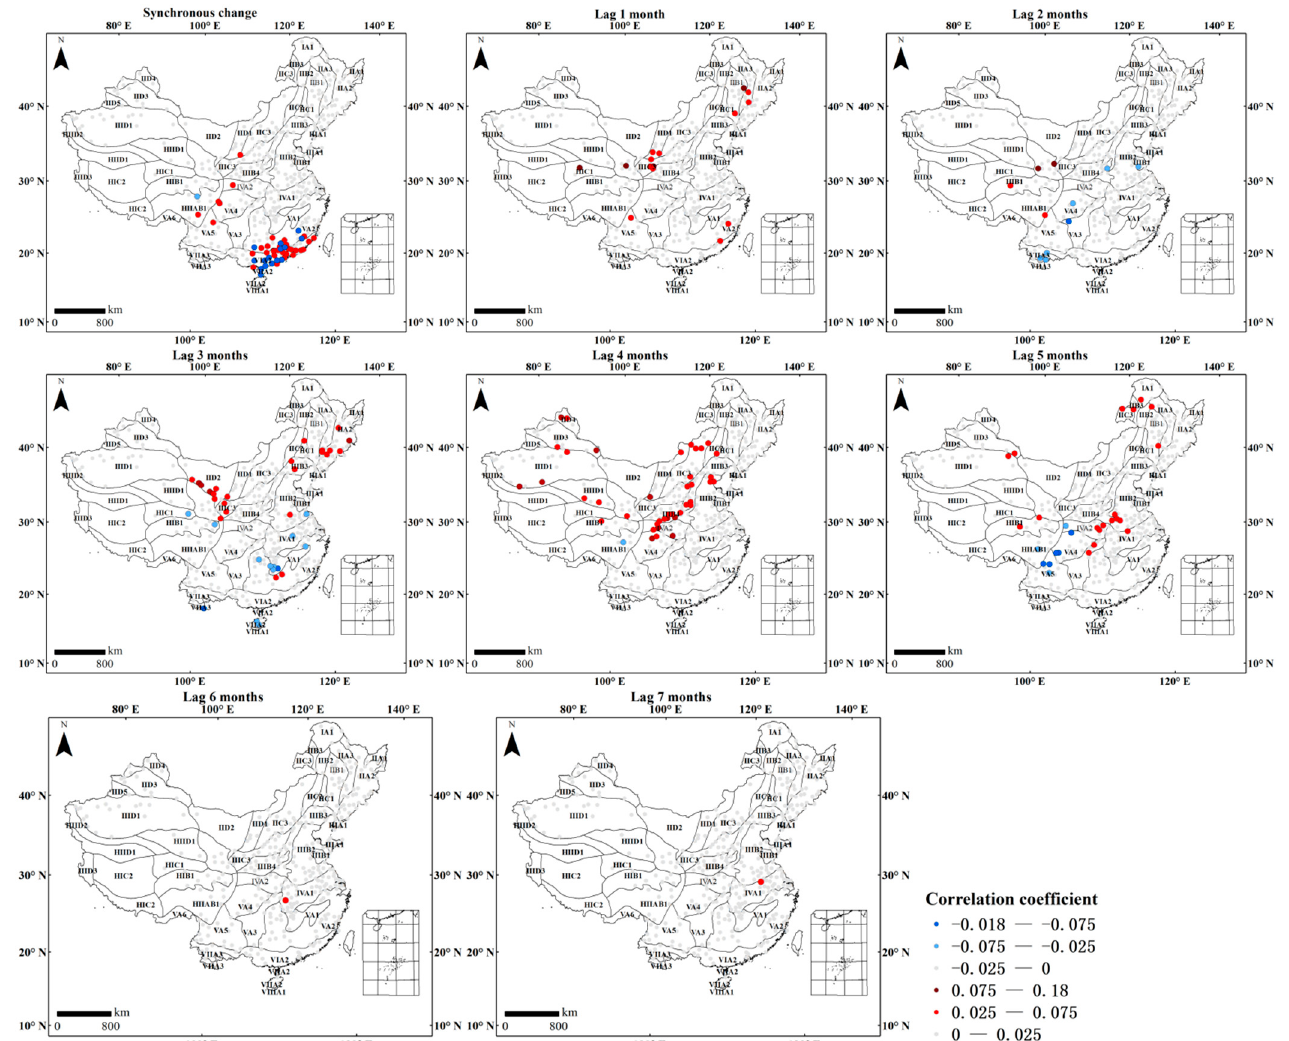
Figure 5. Severity and time lag of drought due to strongest El Niño event (identified by MEI). Using the MEI, the weakest El Niño event extends from August 2006 to January 2007. Compared with the strongest El Niño event, the weakest El Niño event produces a smaller drought region, with the drought ranging from 30° N to 45° N in the coastal areas of China in the east and to the mid-temperate Tarim Basin in the west. During the development of the weakest ENSO event, the impact of drought in China is relatively scattered. The strongest correlation is between El Niño events and droughts with a time lag of 3–5 months, and the drought range gradually expands from the south subtropical region to the north and northwest regions (see Figure 6).